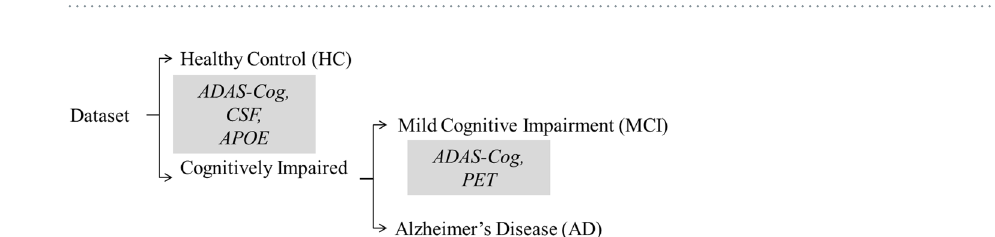
Table 1. Summary of related previous work.